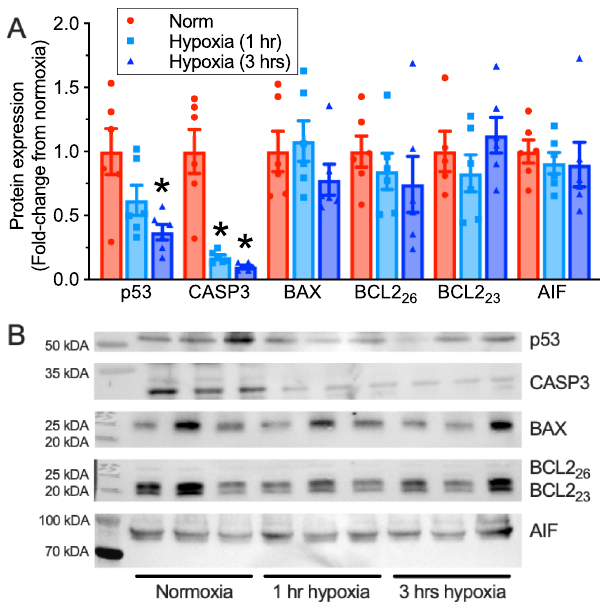
Fig. 8 Apoptosis is not activated during hypoxia. A Summary of the expression of apoptosis regulatory proteins in interscapular brown adipose tissue (iBAT) homogenates from naked mole-rats held at 30 °C in normoxia (21% O 2 , red bars; n = 6 biologically independent samples) or after 1 or 3 h of hypoxia (7% O 2 , light and dark blue bars, respectively; n = 6 biologically independent samples). B Western blot images of protein bands from ( A ). Data are mean ± SEM. Asterisks indicate signi fi cant difference from normoxic controls (one-way ANOVA with Tukey multiple comparisons test; F 2,15 = 6.087, p = 0.0116 for p53; F 2,15 = 24.64, p < 0.0001 for caspase 3 (Casp3); p > 0.05 apoptosis inducing factor (AIF), Bcl-2-associated X (BAX), and B-cell lymphoma 2 (Bcl-2)). Source data are provided as a Source Data fi le.